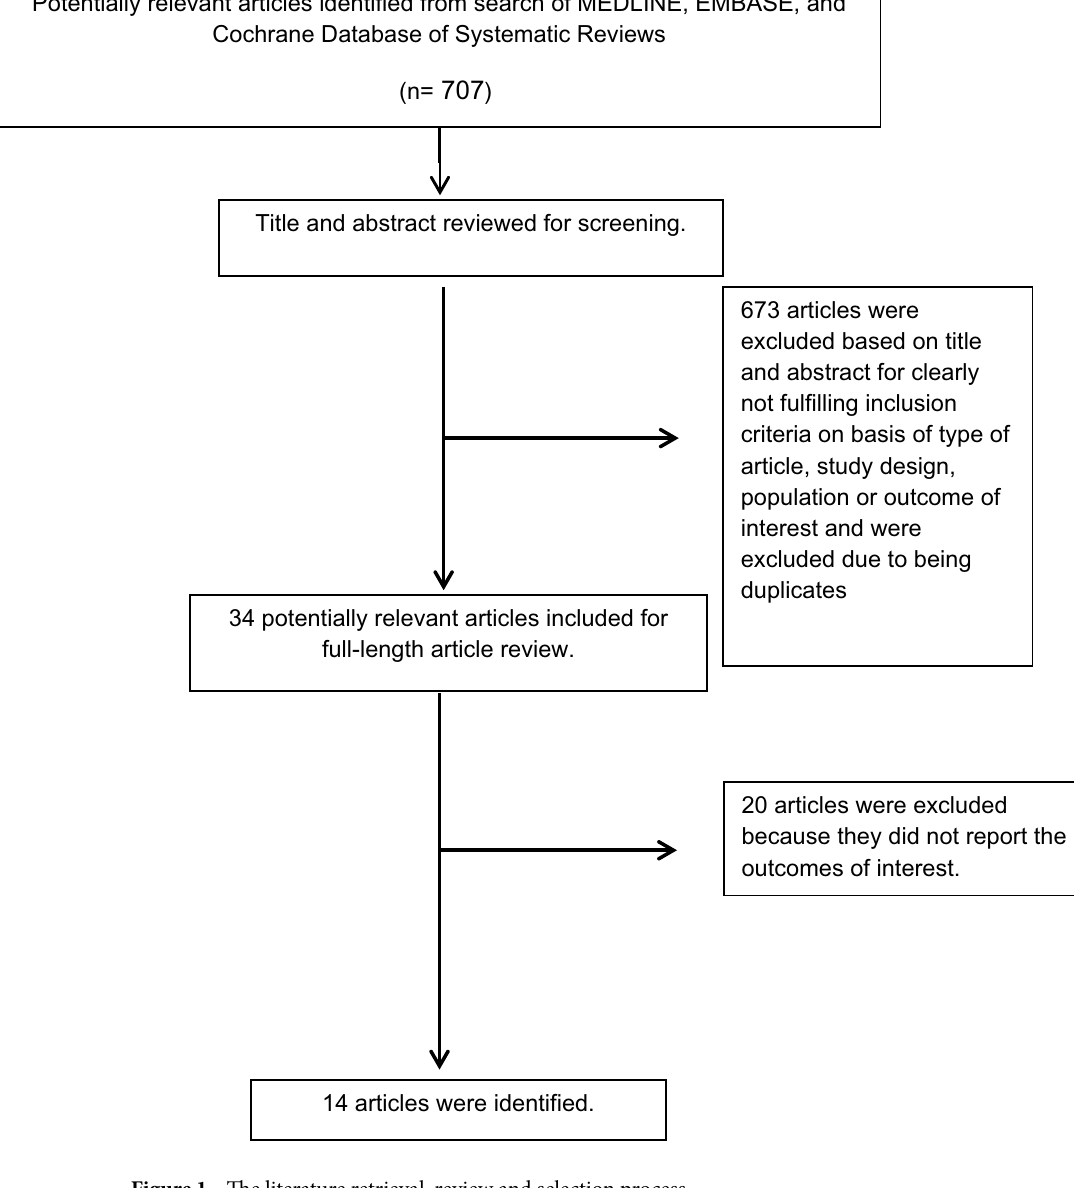
Figure 1. The literature retrieval, review and selection